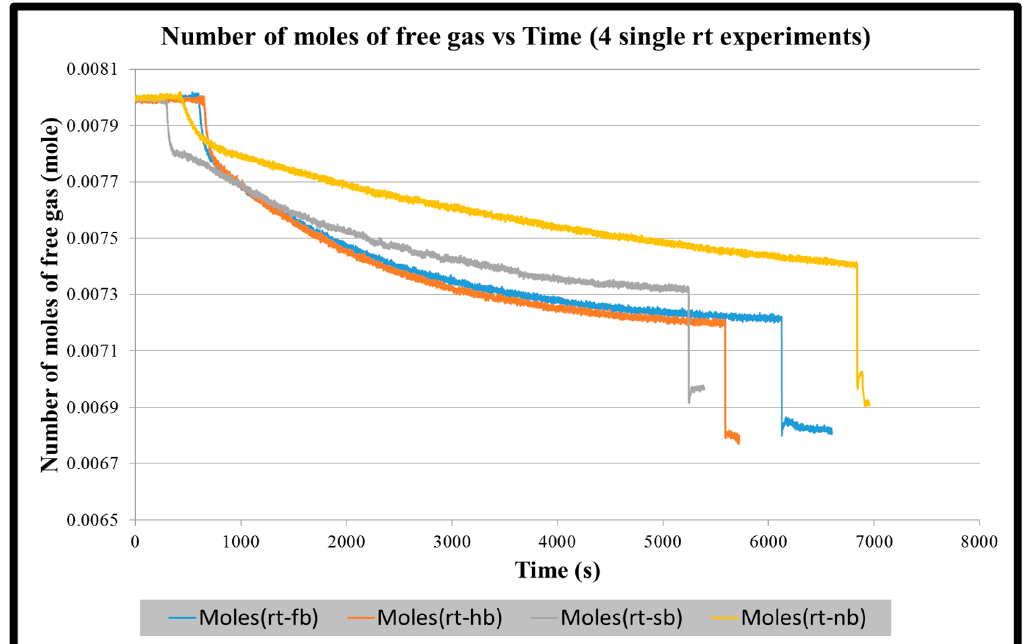
Figure A2. Number of moles of free gas vs. time for four single RT impeller experiments until the start of stabilization of hydrate formation .